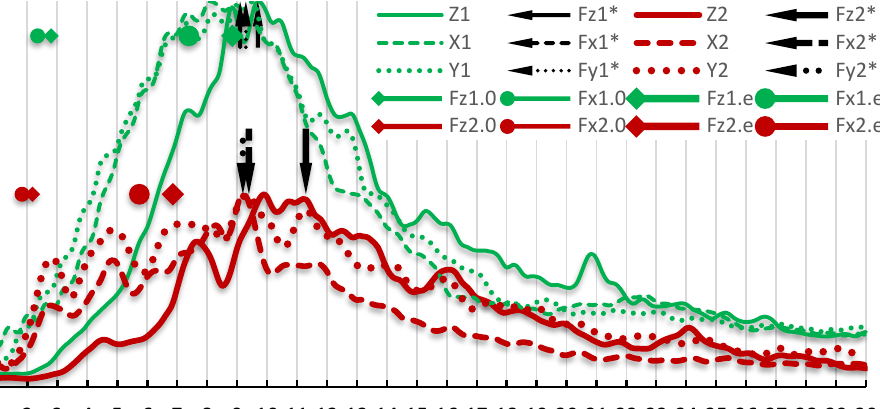
Fig. 2. Instrumental amplitude-frequency spectra of seismograms of the investigated building from 1 to 30 Hz and points with calculated values of natural frequencies of an equivalent subsoil according to formula (1) and SP